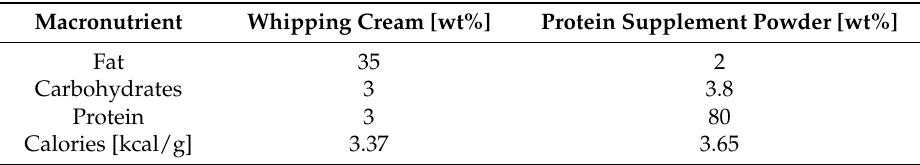
Table 1. Macronutrient composition of ketogenic meals.